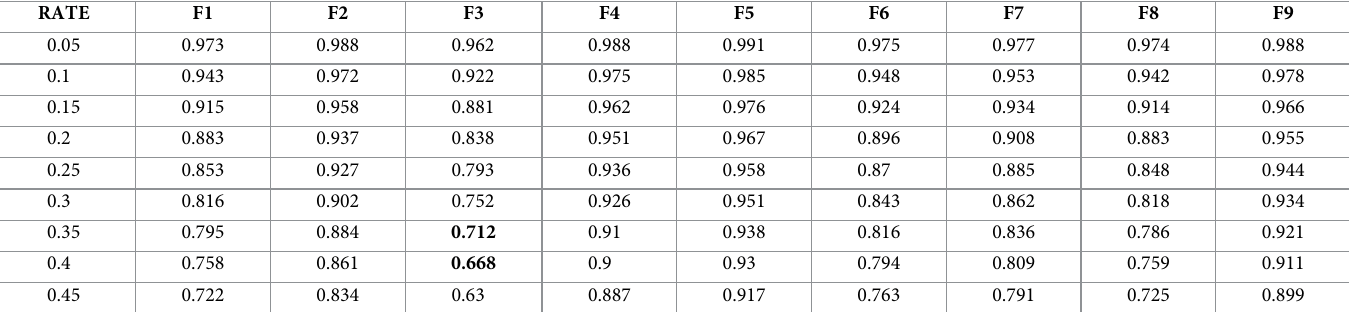
Table 11. Accuracy of MICE by feature.